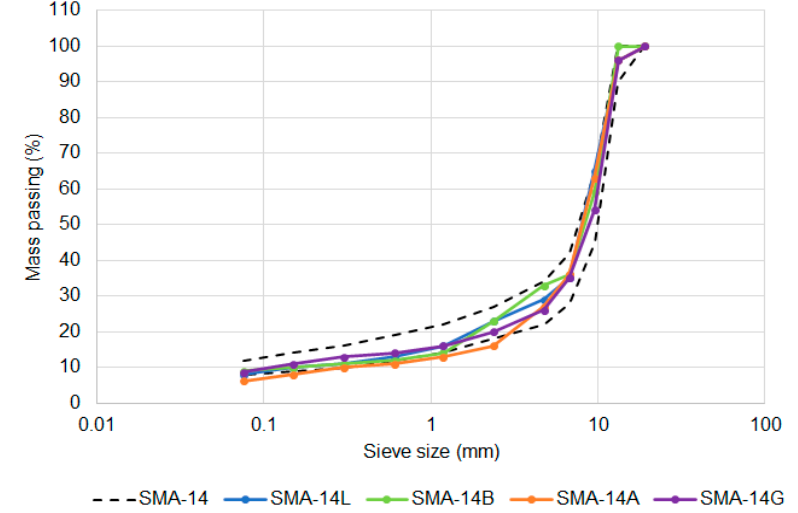
Figure 6. SMA-14 gradations compared to target.